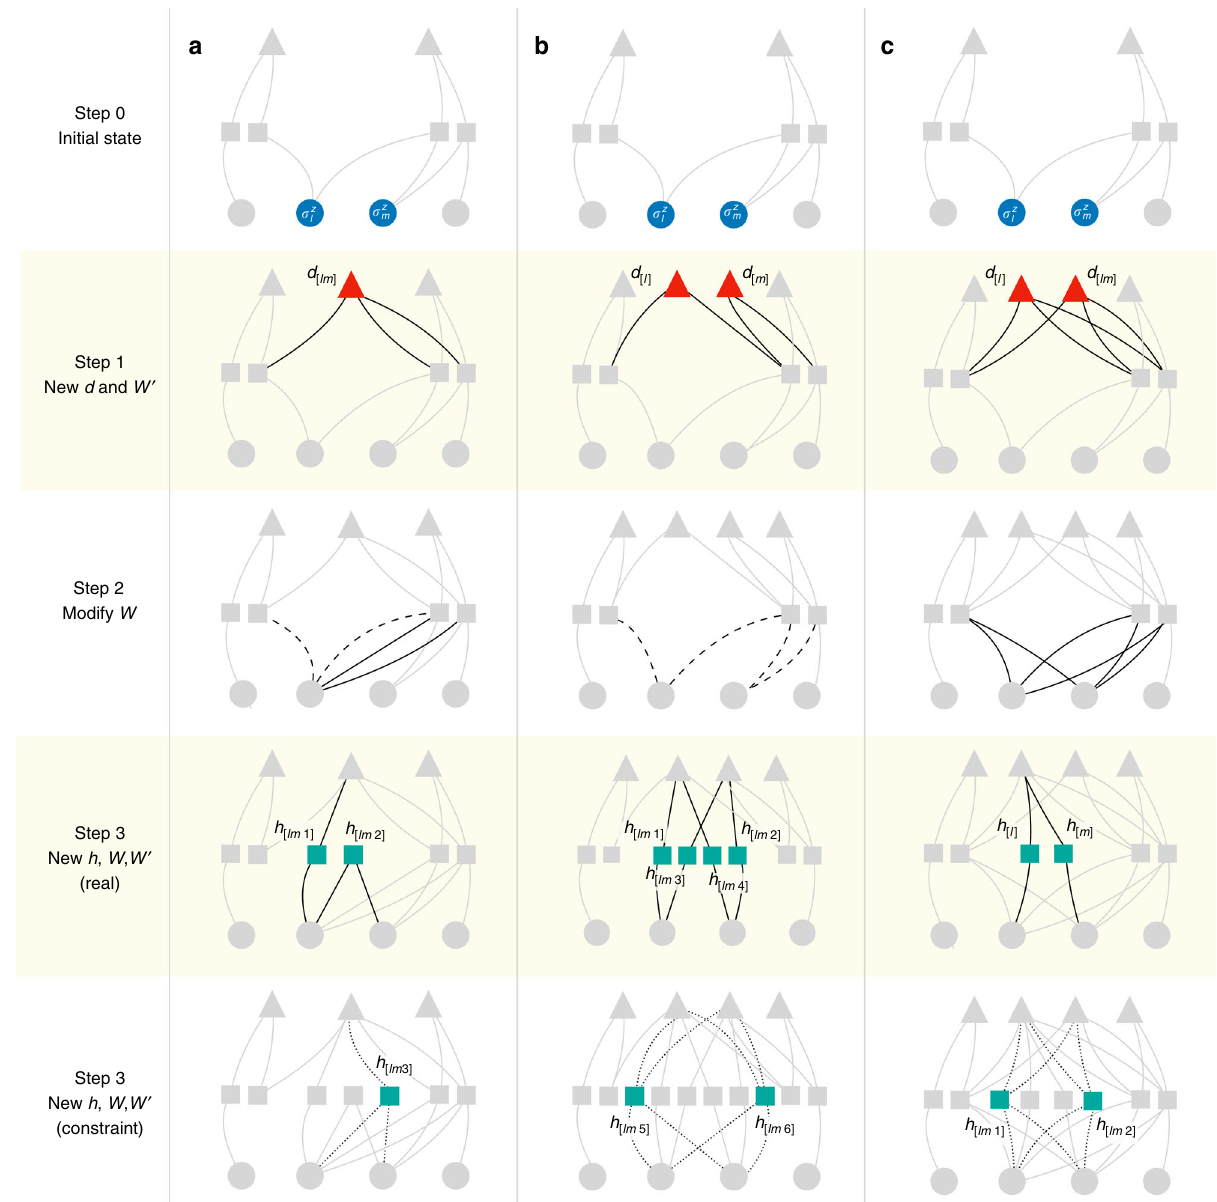
Fig. 3 Construction of exact DBM representations of Heisenberg models. In this example, a time step of imaginary-time evolution is shown, for the case of (cid:5) (cid:6) the one-dimensional antiferromagnetic Heisenberg model. Dots represent physical degrees of freedom σ z i , squares represent hidden units ( h j ), triangles represent deep units ( d k ). The three panels ( a – c ) represent different possible explicit constructions. In each panel, upper networks are the initial state with arbitrary network form, and the bottom networks are the fi nal states, after application of the propagator. Intermediate steps illustrate how the network is modi fi ed, where the relevant modi fi ed weights at each step are highlighted in black. In those diagrams, dashed lines indicate that the corresponding weights are set to zero, and dotted lines indicate complex-valued weights. The three panels correspond to the ( a ) “ 1 deep, 3 hidden ” (1d – 3h), ( b ) “ 2 deep, 6 hidden ” (2d – 6h), and ( c ) “ 2 deep, 4 hidden ” (2d – 4h) constructions (see text for a more detailed explanation of the individual steps characteristic of